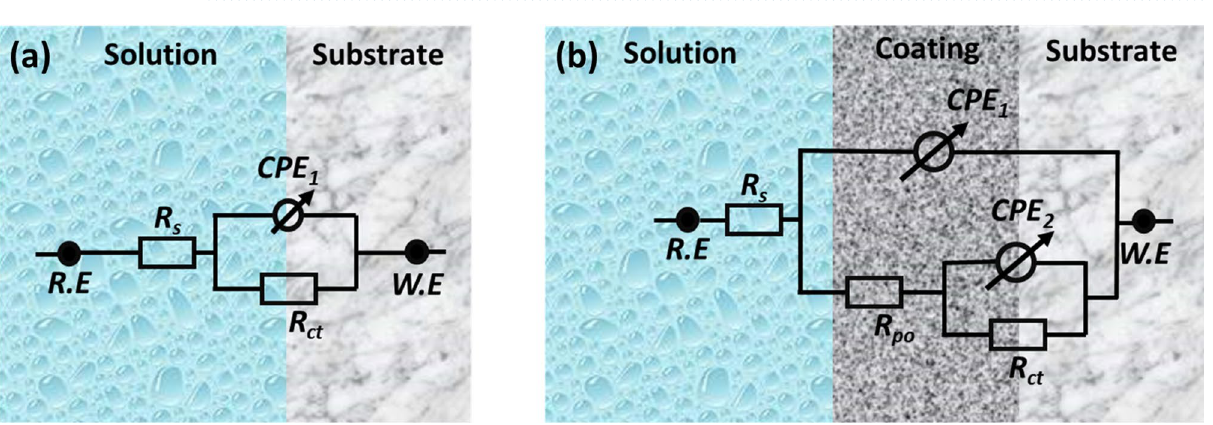
Figure 13. Equivalent electric circuit used for fitting the experimental EIS data for ( a ) polished carbon steel used as substrate, ( b ) Ni–P and Ni–P–TiC composite coatings containing different concentrations of TiC